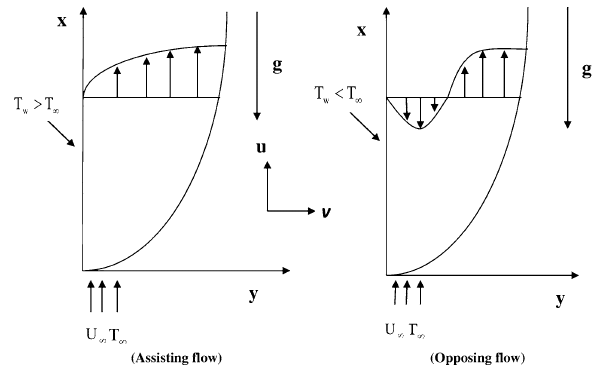
Fig. 1 Buoyancy-induced a assisting and b opposing